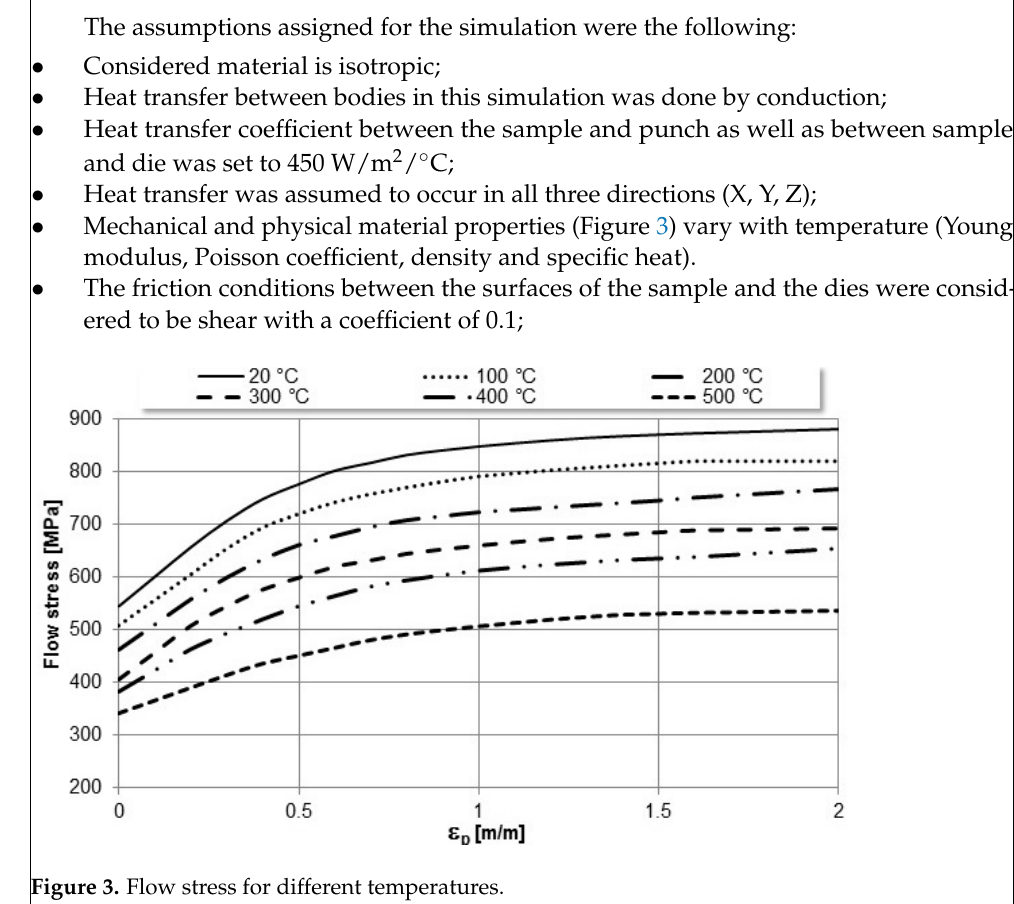
Figure 2. Simulation bodies: ( a ) upper punch geometry, ( b ) 3D upper punch, ( c ) active part of upper punch, ( d ) sample, ( e ) lower punch.